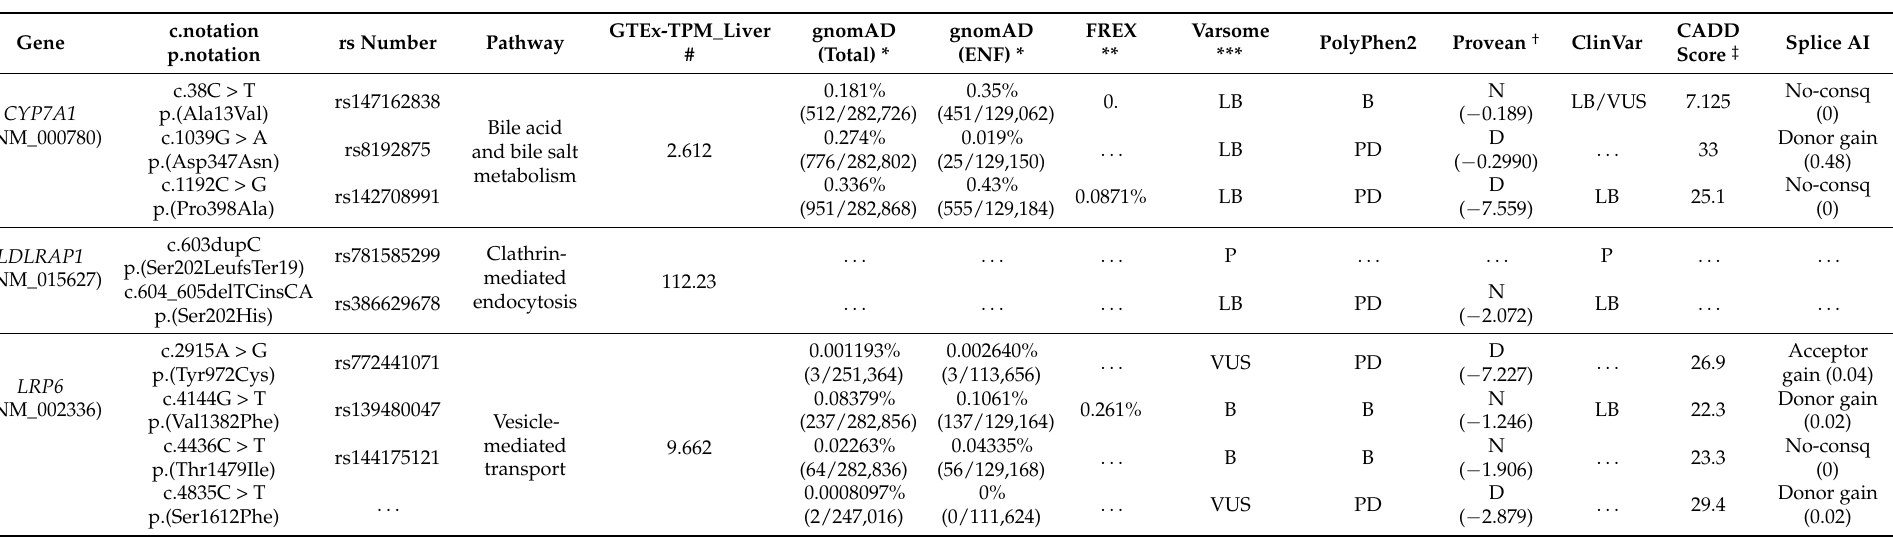
Table 1. Variants in CYP7A1 , LDLRAP1 and LRP6 . The pathogenicity of the variants was evaluated using Varsome, PolyPhen2, Provean, ClinVar, CADD score and Splice